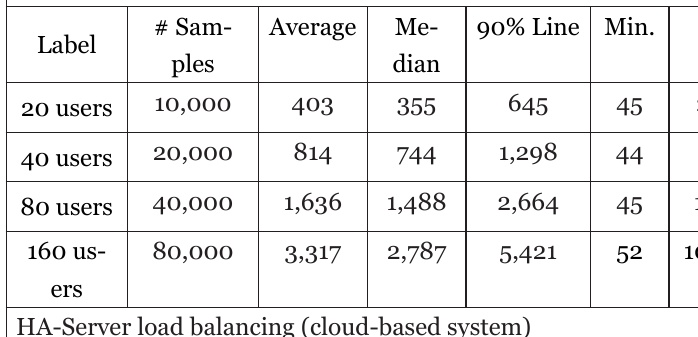
Single Virtual Machine (stand-alone